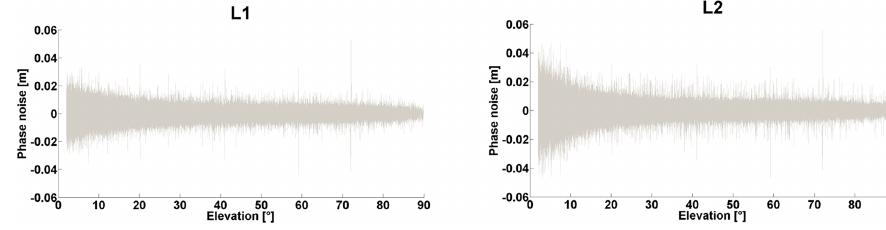
Figure 5. Carrier phase noise for (cid:49) 2 L 1 and (cid:49) 2 L 2 at midlatitude areas on DoY 333, 2015, plotted against